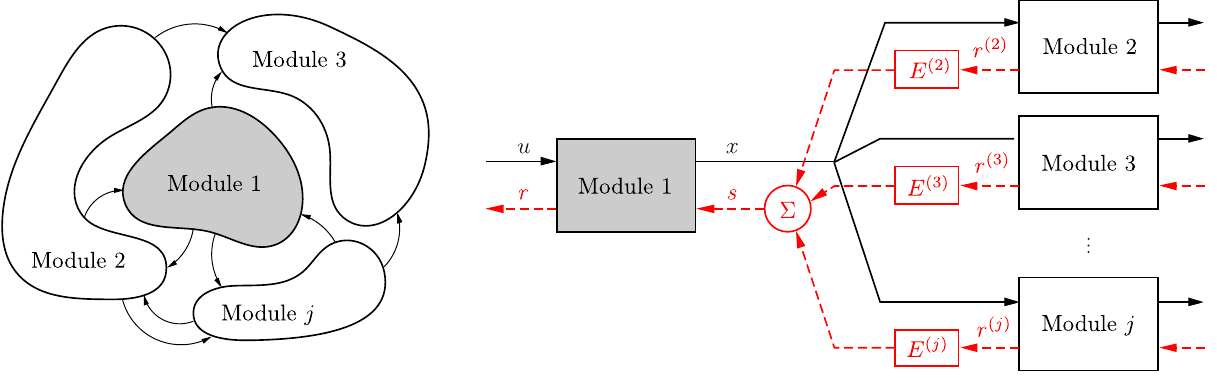
Figure 1. The dynamics of a module depend on the module’s context. Downstream modules change the dynamics of an upstream module by applying a load. The effect of this load is captured by the retroactivity to the output s of the upstream module, which is the weighted sum of the retroactivity to the input r ( i ) of the downstream modules.